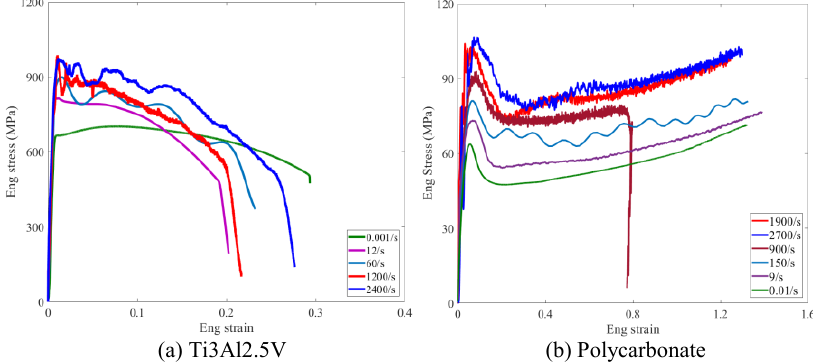
Fig.2 Engineering stress-strain relationship of two materials from low to high strain rates